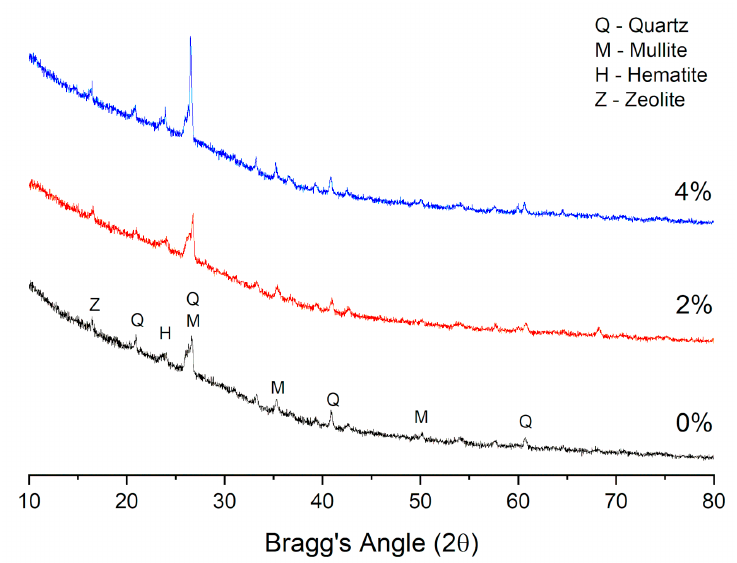
Figure 7. XRD patterns of unexposed fly ash geopolymers with varying silica fume contents.